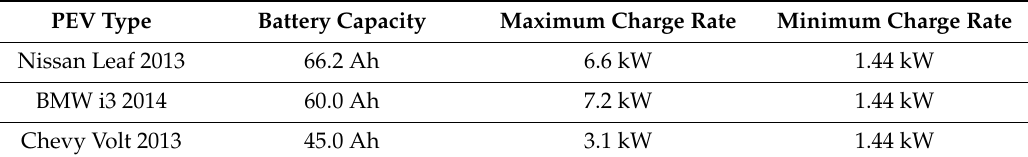
Table 2. PEV battery and charging parameters